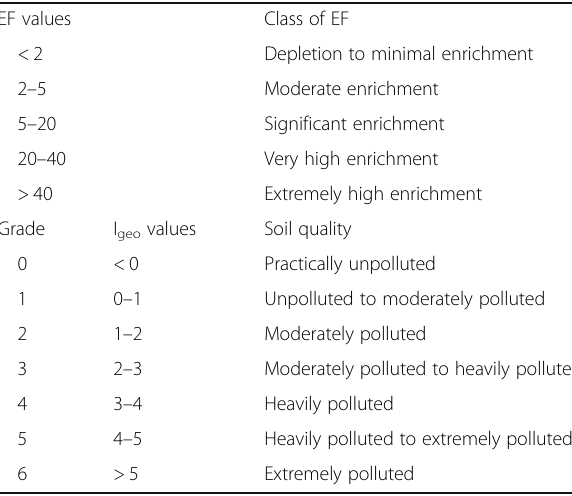
Table 1 Classification of enrichment factor (EF) and